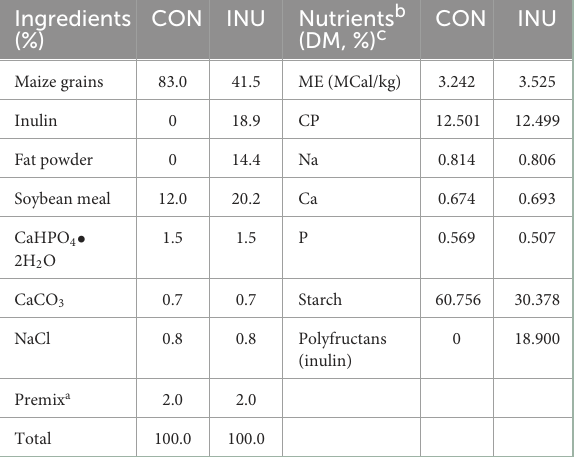
TABLE 1 The ingredients and nutrient composition of experimental concentrates fed to weaned kids. Ingredients